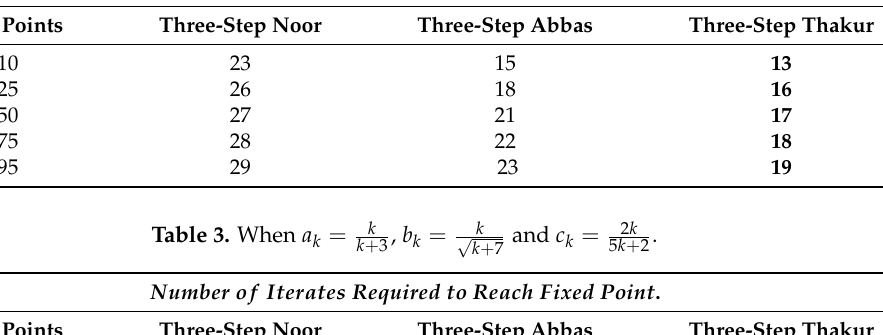
Table 2. When a k = k Number of Iterates Required to Reach Fixed Point .